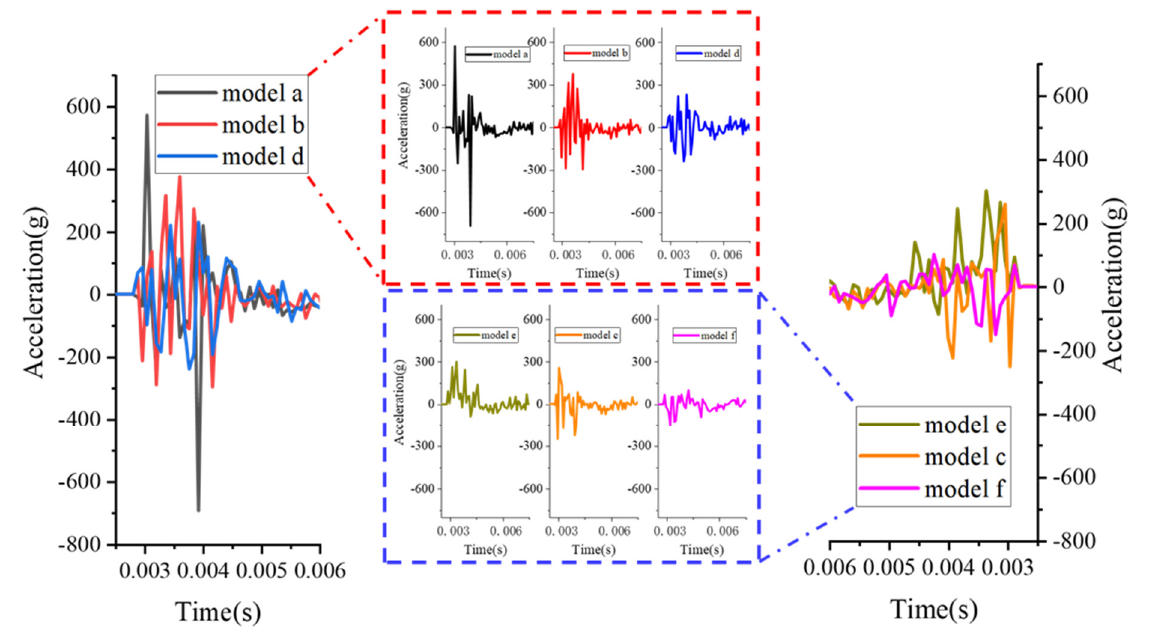
Figure 15. Acceleration (Y ‐ direction, i.e., vertical) in the hance with understanding blast load of 0.3 kg TNT with stand ‐ of distance of 1 m.